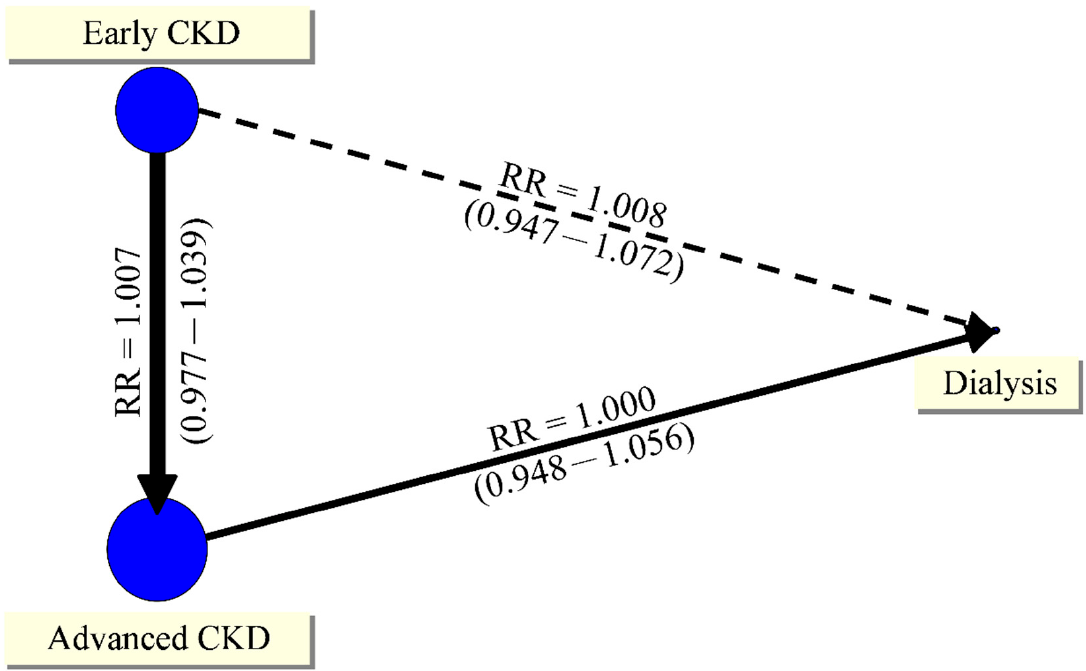
Figure 2. Network plot of sustained virologic response at post-treatment week 12 among patients with different renal conditions. RR, risk ratios; CKD, chronic kidney disease.